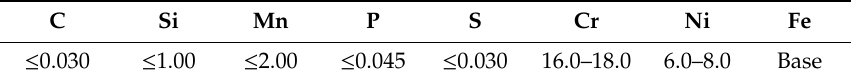
Table 1. The chemical composition of 301L stainless steel (wt.%).